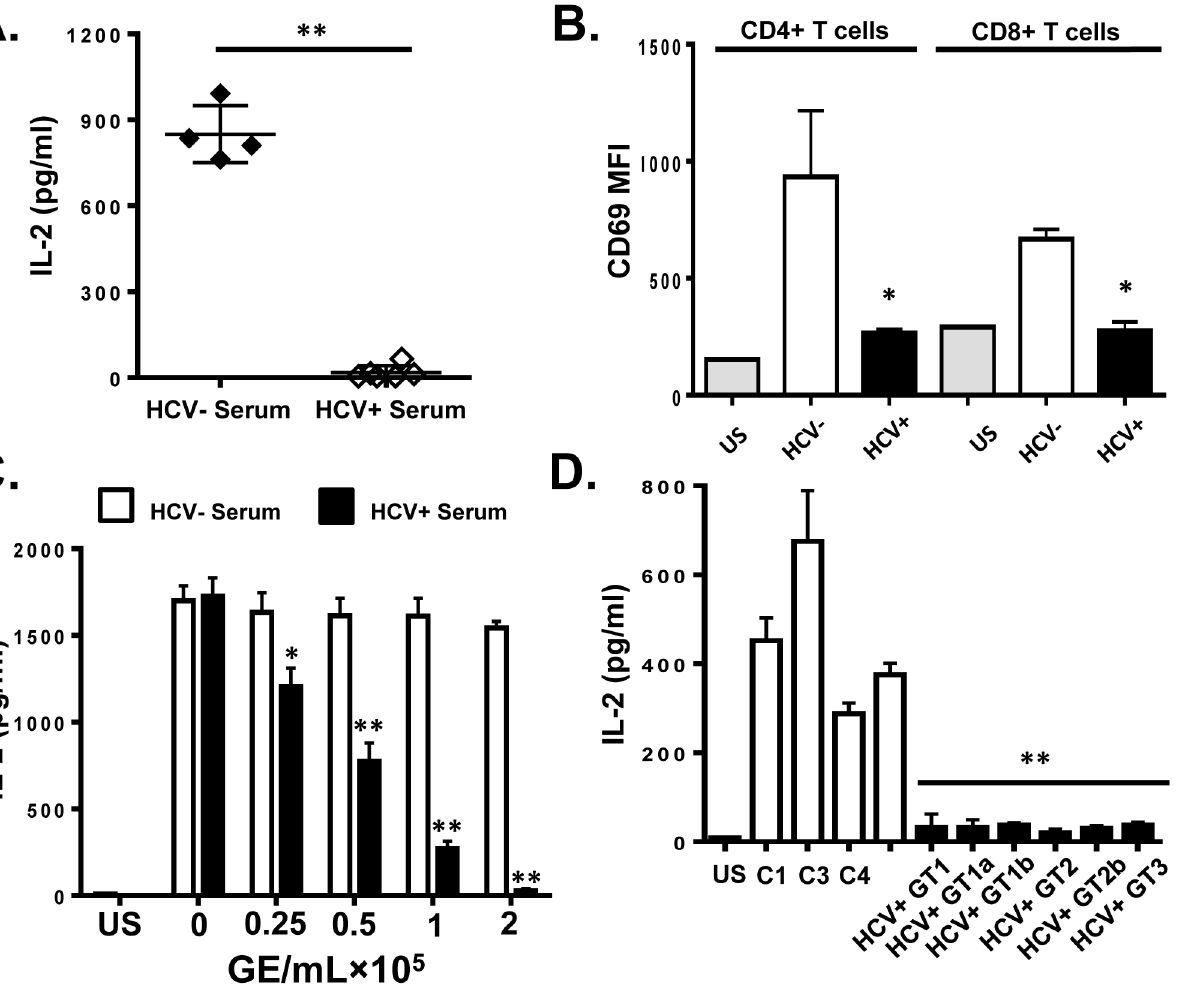
Fig 1. HCV serum particles inhibit T cell receptor (TCR) signaling in primary human T lymphocytes. Healthy donor PBMCs were incubated with serum obtained from HCV positive (HCV+) humans infected with various genotypes and subtypes (GT; 1, 1a, 1b, 2, 2b, and 3) or HCV negative control serum (C1-C4) and IL-2 release (A) and CD69 surface expression (B) were measured following TCR stimulation with anti-CD3/CD28. CD69 MFI represents the average of four HCV negative and six HCV-positive sera samples. TCR-induced IL-2 release by human PBMCs incubated with various doses of pooled HCV positive or HCV negative serum (C). IL-2 release by purified primary human CD3+ T cells incubated with HCV-positive sera from genotypes (GT; 1, 1a, 1b, 2, 2b, and 3) or HCV negative serum (C1-C4) (D). US = unstimulated cells. MFI = mean fluorescent intensity. Data represent the average of three technical replicates and the standard deviation is shown. Each experiment was independently performed with three different donors with similar results. * P < 0.05; ** P <